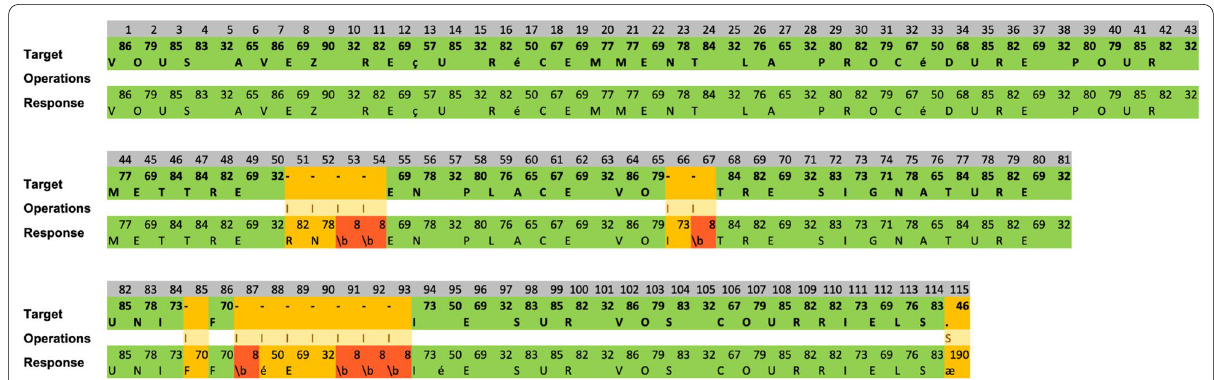
Fig. 3 Example of quantification of accuracy through sequence comparison. Differences between the target (top row) and response sequences (bottom row) are shown as operations (I insertion, S substitution) in yellow, backspaces (“\b”) in red. In this example, the distance between = = sequences (or IDS) is